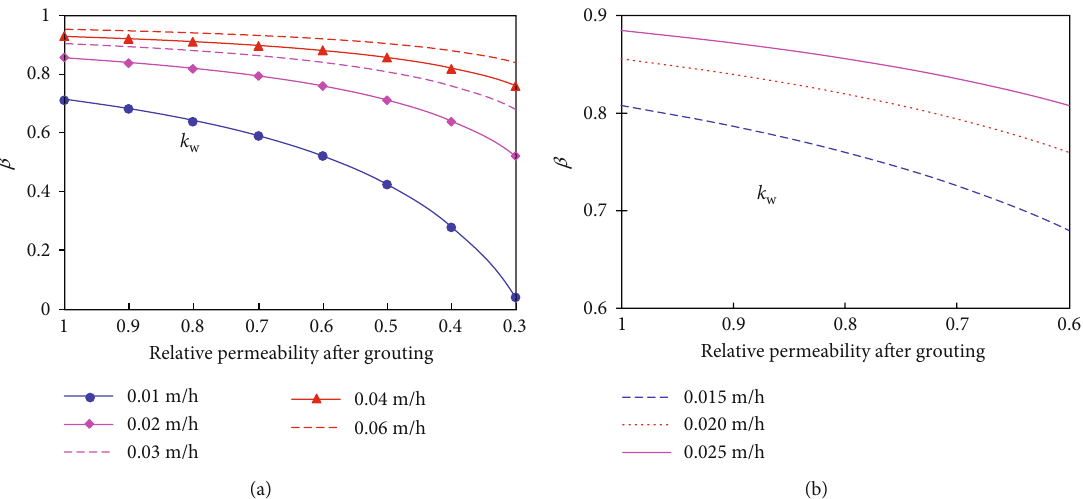
Figure 7: Relationship between water pressure reduction coe ffi cient with the grouting e ff ect: (a) di ff erent initial permeability; (b) enlargement of grouting in fl